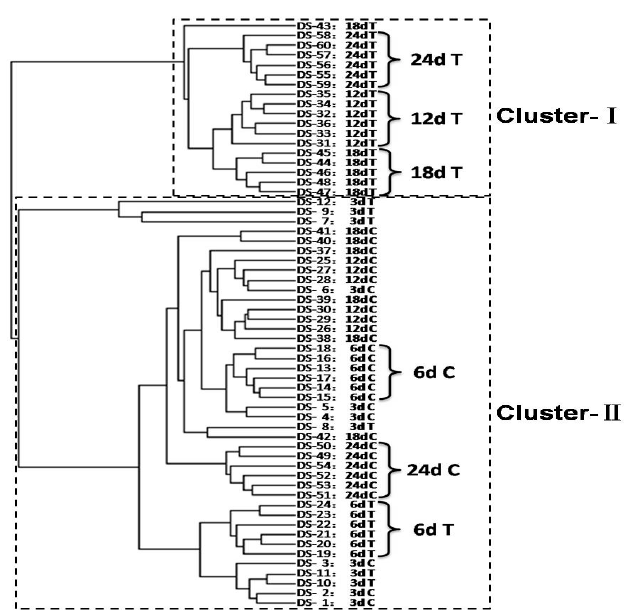
Figure 3. Hierarchical cluster analysis (HCA) dendrogram derived from UHPLC-HRMS data both in positive and negative modes for extracts obtained from the control (C) and PSF-treated (T) S. miltiorrhiza hairy roots collected 3, 6, 12, 18, and 24 d post-elicitation.